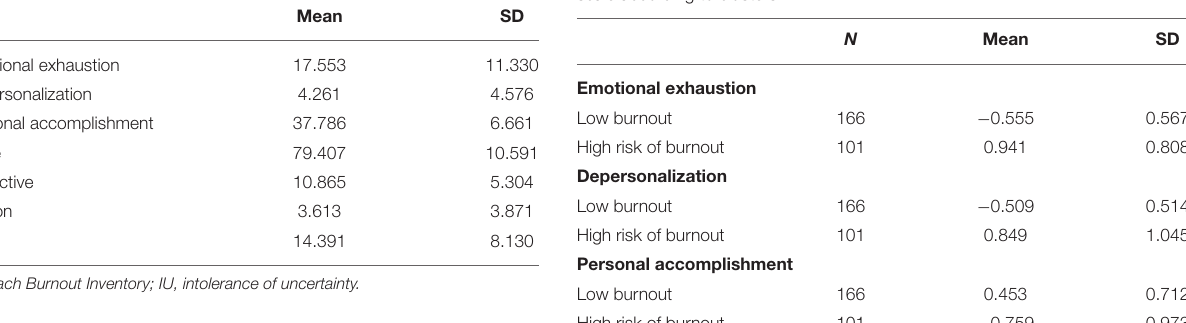
TABLE 2 | Mean and SD for each dimension evaluated. TABLE 3 | Mean scores and standard deviations for each dimension of the MBI scale according to